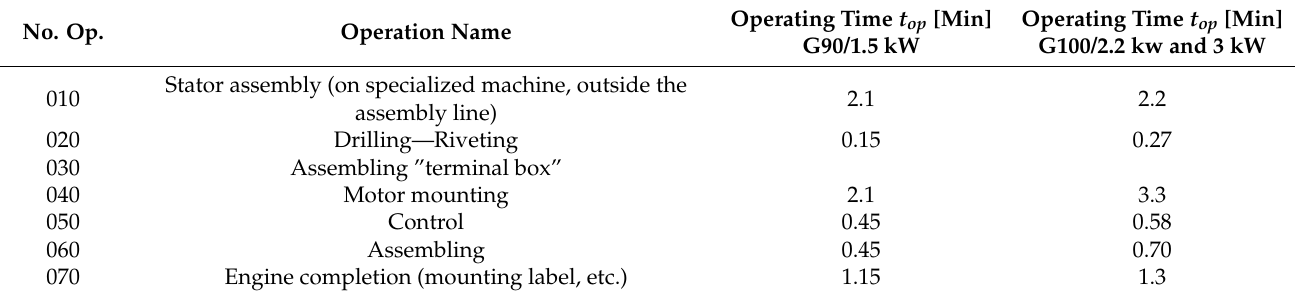
Table 2. Determination of the annual and monthly effective time fund for one shift.